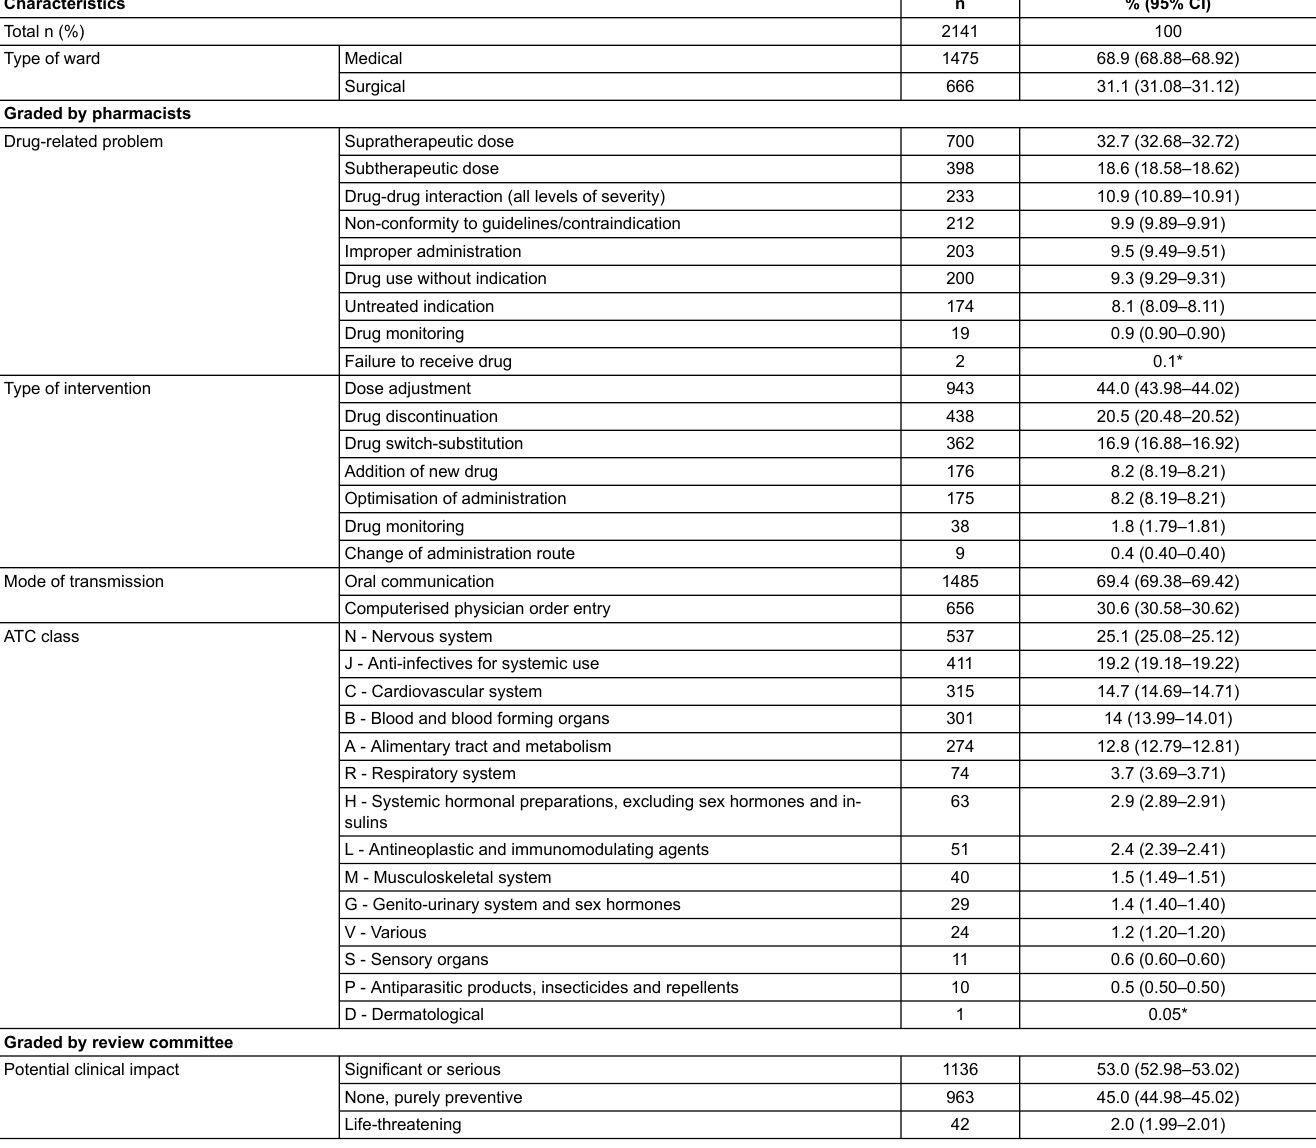
Table 1: Characteristics of the 2141 investigated and appropriate interventions by pharmacists.